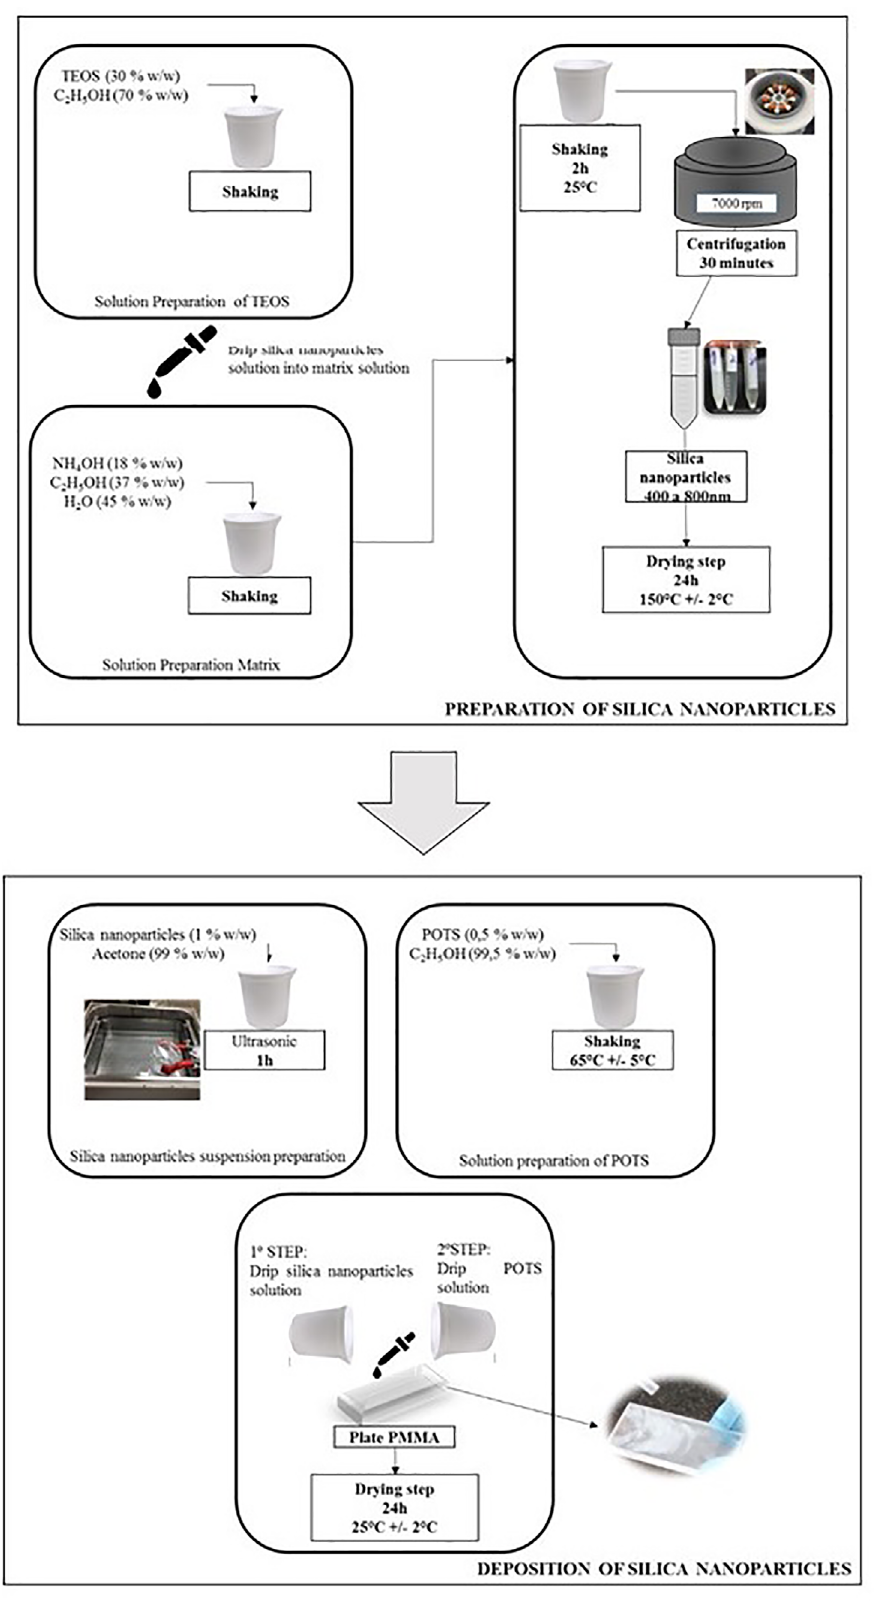
Figure 1. Silica nanoparticle preparation and deposition process